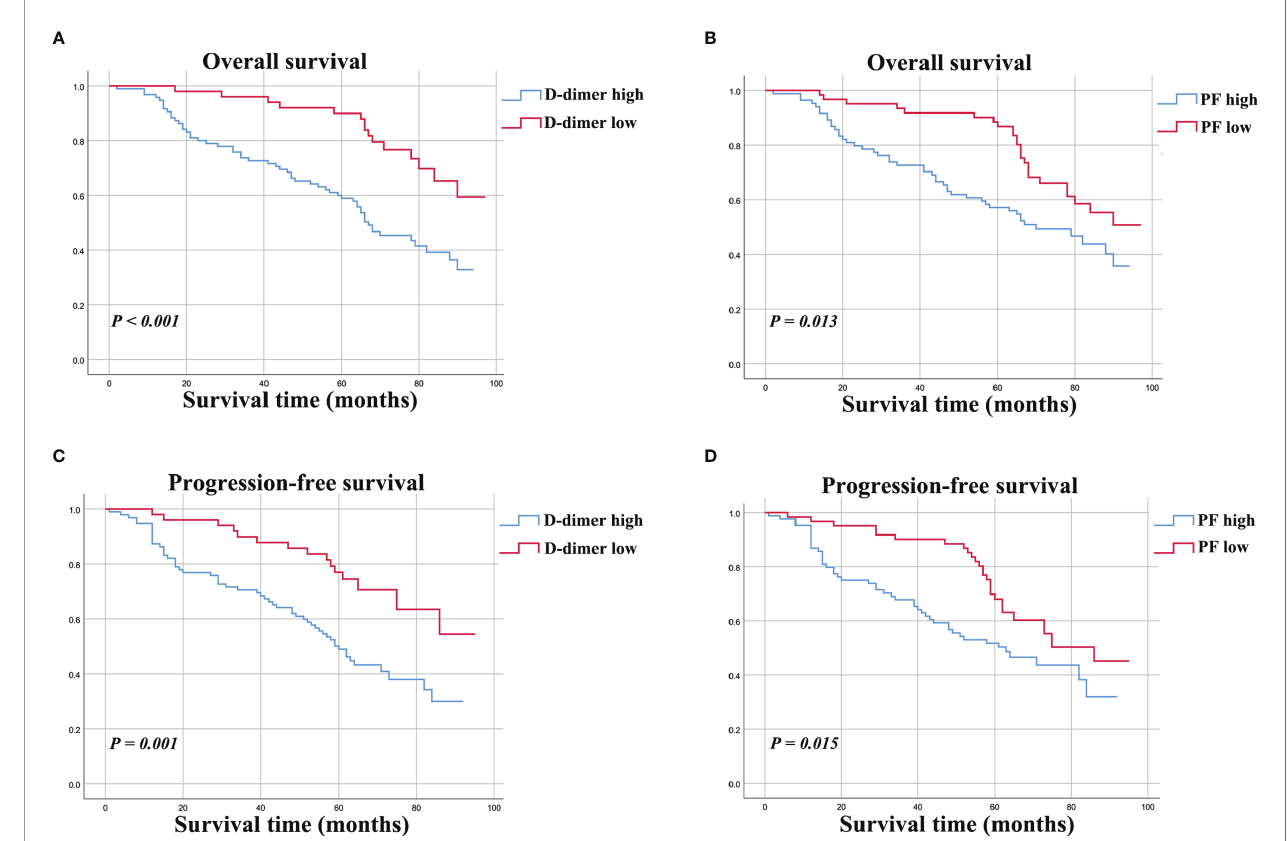
FIGURE 2 | Kaplan-Meier curves for OS (A, B) and PFS (C, D) for osteosarcoma patients strati fi ed by preoperative D-dimer and